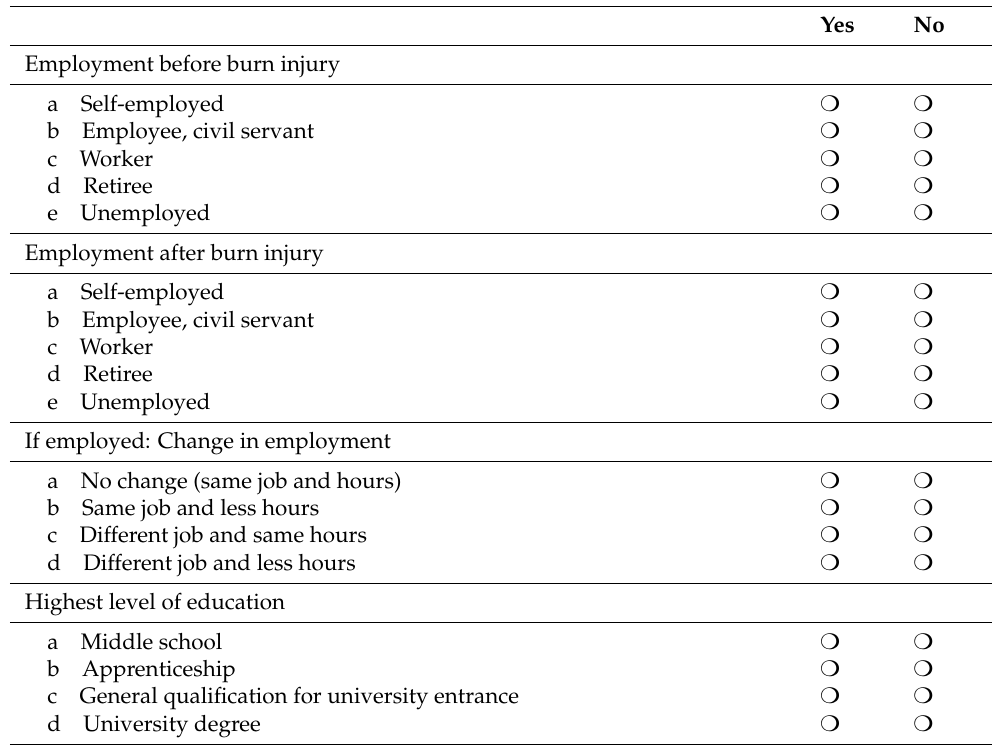
Table 1. Complementary